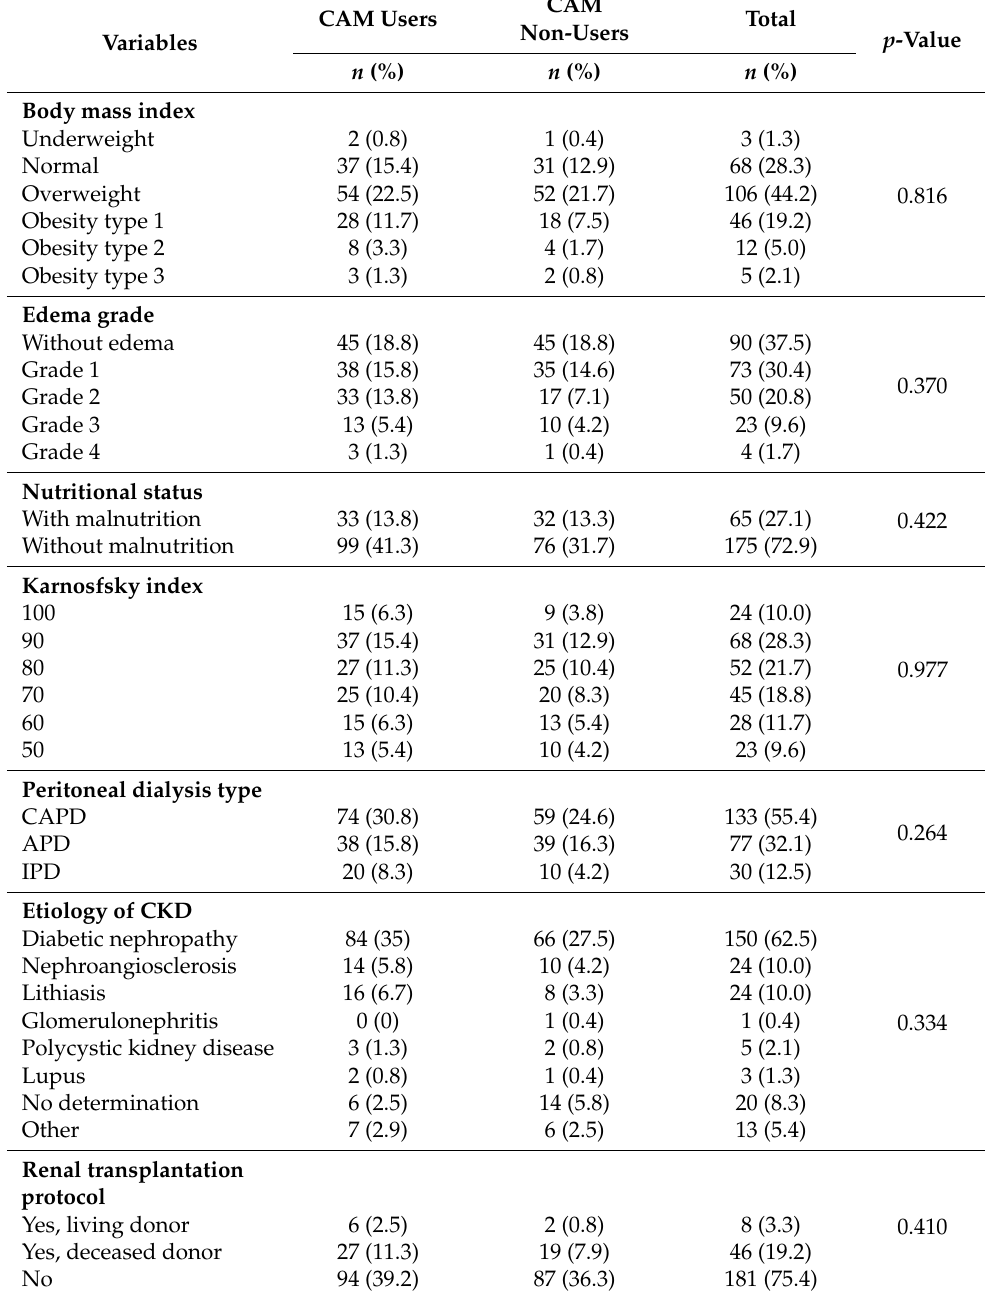
Table 4. Clinical characteristics of